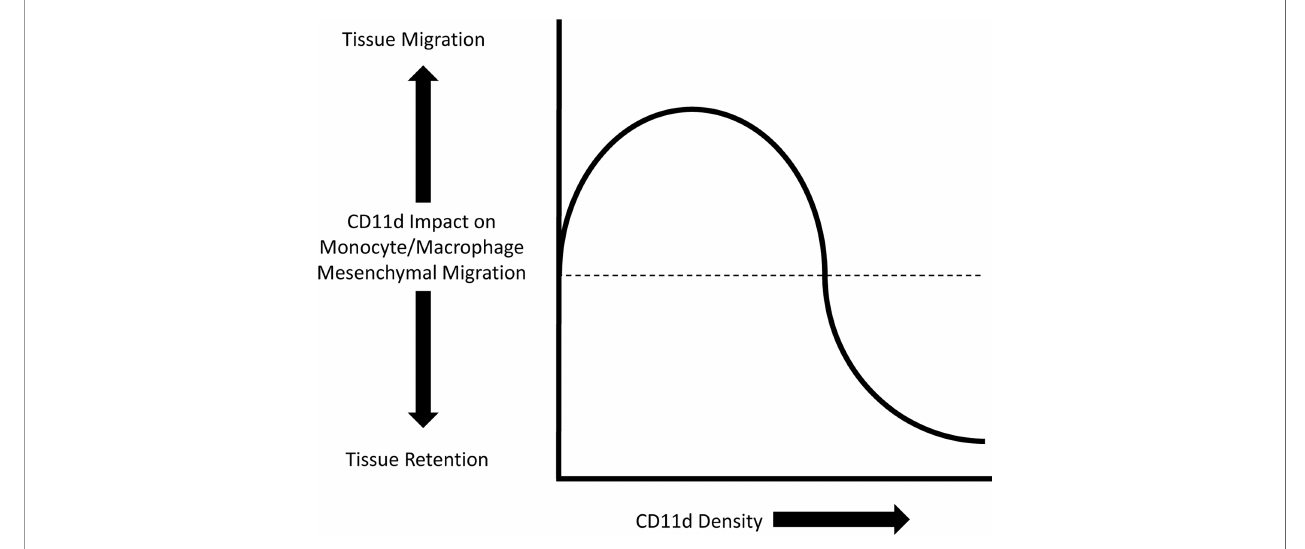
FIGURE 4 | Representation of the impact CD11d density has on monocyte/macrophage mesenchymal migration. Low density of CD11d expression supports migration, while high densities inhibits migration and promotes tissue retention